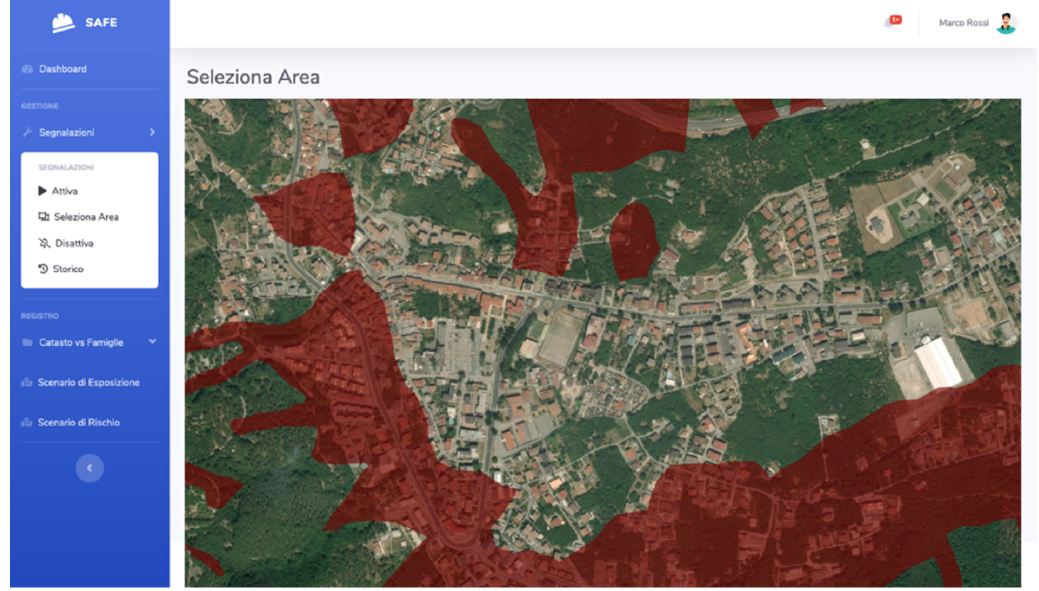
Figure 14. Selecting the risk area associated to a new phenomenon.